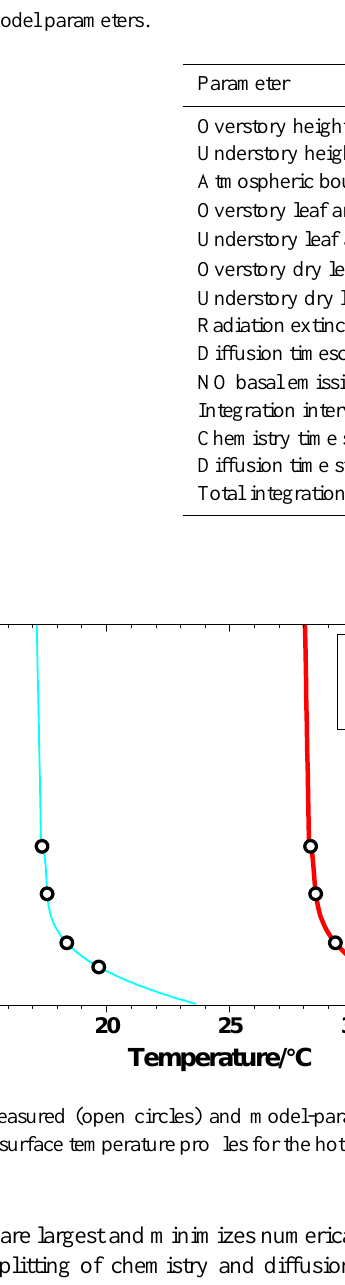
Table 1. Model parameters.